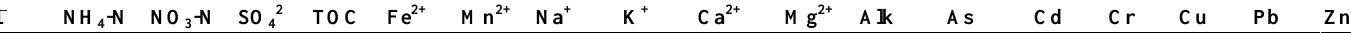
Table 2. The correlation coefficient matrix for hydrochemical